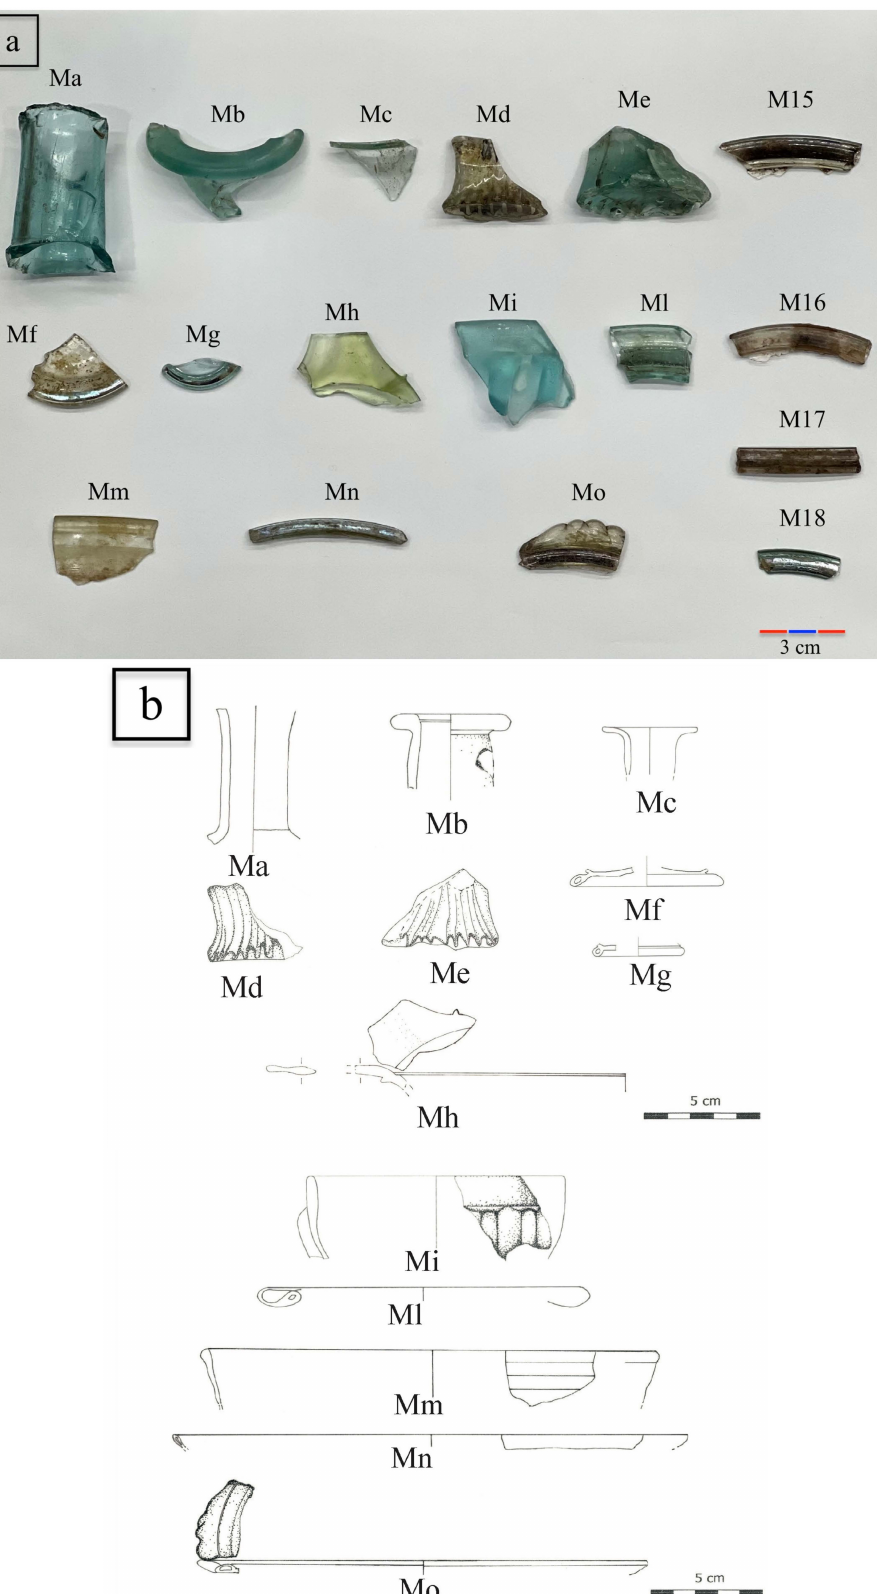
Figure 2. ( a ) Photograph of Muricelle glasses analysed in this study; ( b ) possible shape attribution of the vitreous